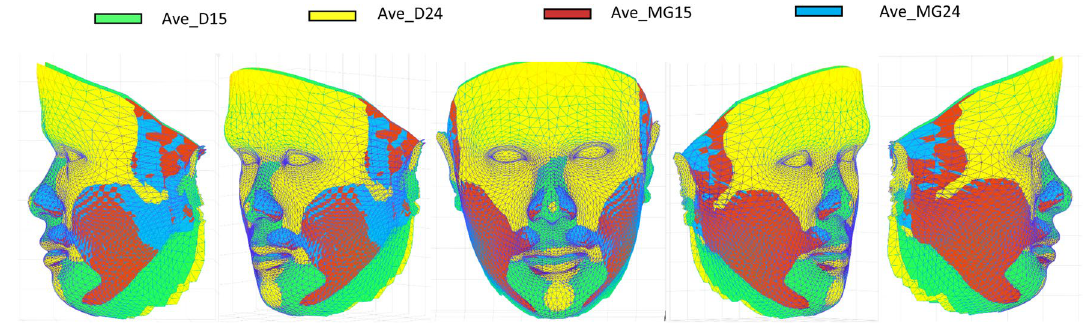
Figure 5. Superimposed average faces, based on the generic mesh and Di3DView (Ave_D15 and Ave_D24), and MorphAnalyser (Ave_MG15 and Ave_MG24).